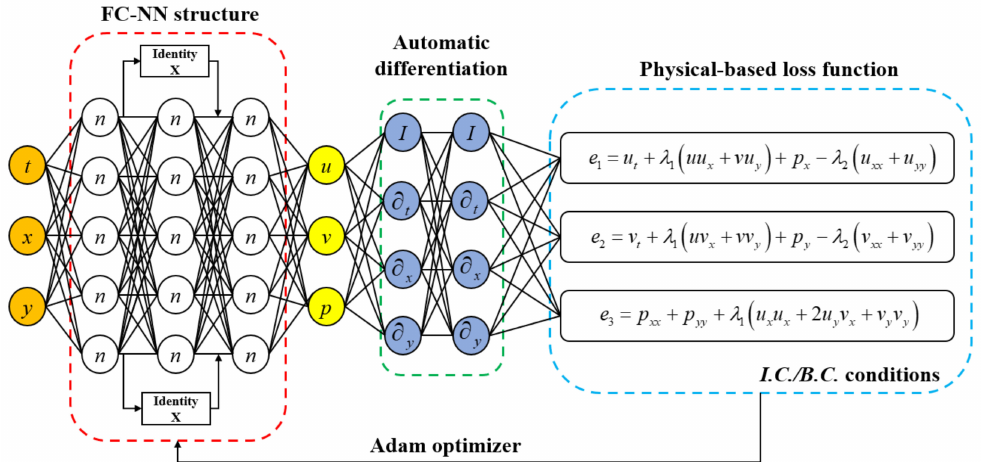
Figure 8. Navier-Stokes equation informed neural network (cavity